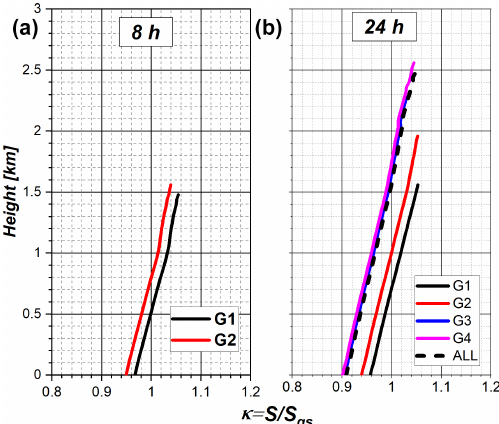
Figure 3. Vertical profile of the ratio of supersaturation to its quasi- steady value. (a) The early stage of cloud formation (time = 8h). (b) the mature stage of cloud system development (time = 24h). The vertical coordinate is the height above the cloud